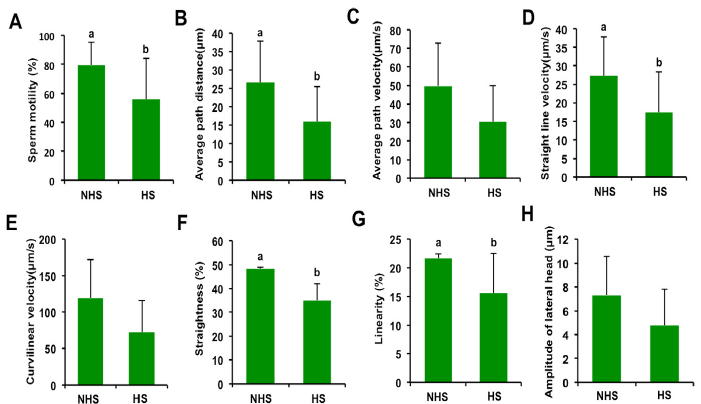
Figure 1. Effect of heat stress on kinetic parameters of boar sperm. ( A ) Sperm motility in NHS and HS groups. Kinetic parameters of sperm, including average path distance ( B ), average path velocity ( C ), straight line velocity ( D ), curvilinear velocity ( E ), straightness ( F ), linearity ( G ), and amplitude of lateral head ( H ), were detected in NHS and HS group. NHS: non-heat-stress, HS: heat stress. All data are shown as mean ± S.E.M, and different letters on the bars indicate significant differences ( p < 0.05).